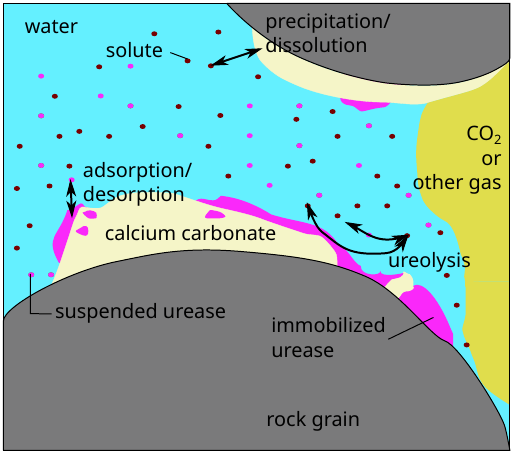
Figure 1. Schematic view of relevant processes and phases considered in the conceptual model, modified from